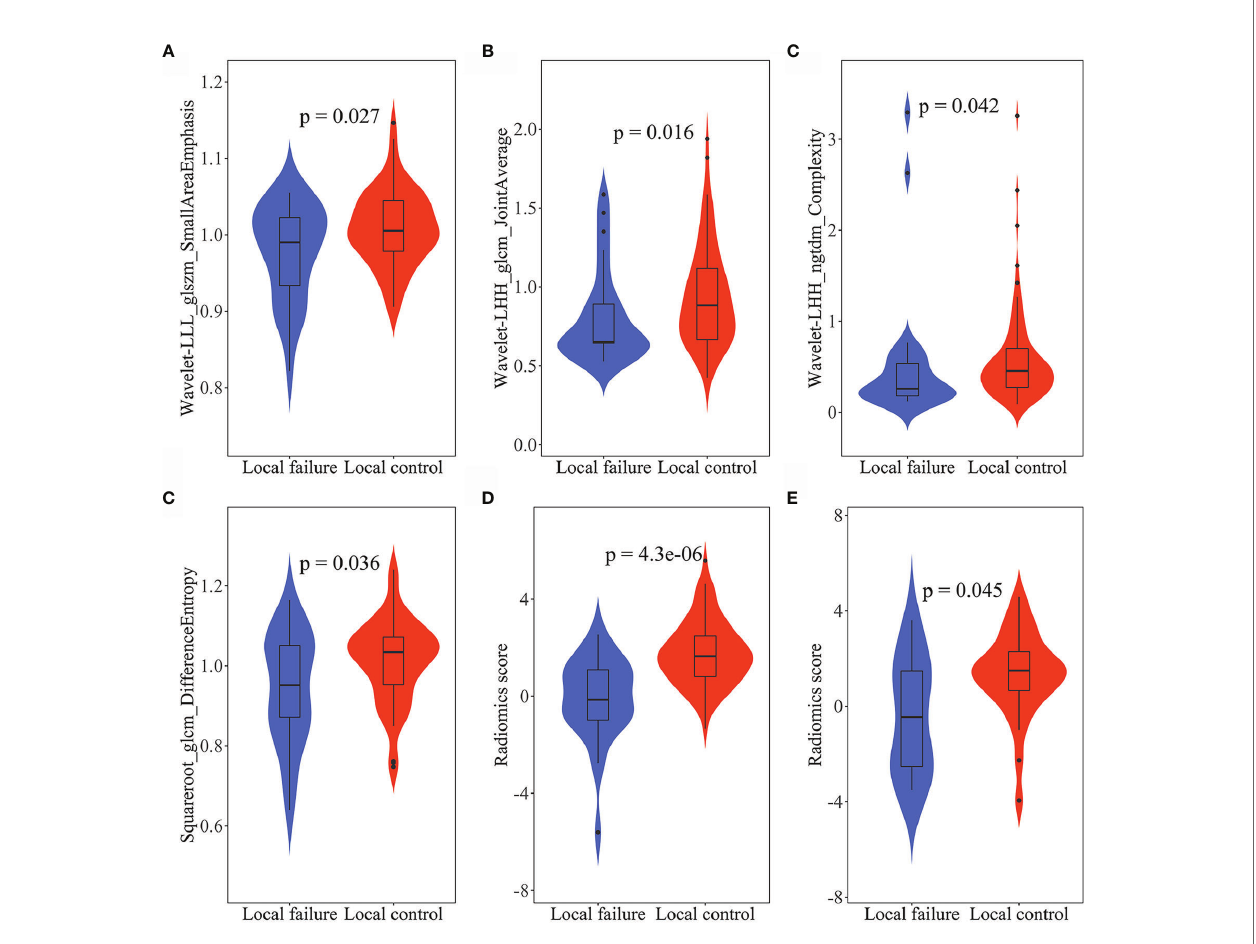
FIGURE 4 | The violin plots of radiomics features and radiomics score. The distribution of (A) wavelet-LLL_glszm_SmallAreaEmphasis, (B) wavelet-LHH_glcm_ JointAverage, (C) wavelet-LHH_ngtdm_Complexity, and (D) squareroot_glcm_DifferenceEntropy in the training group. The distribution of radiomics score in the training group (E) and in the validation group (F) . The p -values were obtained by t -test or Wilcoxon rank sum